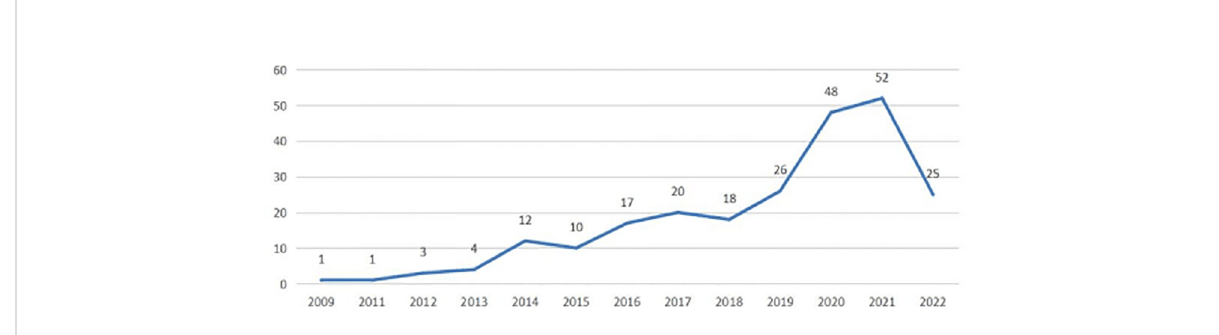
FIGURE 2 Annual statistics of published papers. The abscissa represents time, and the ordinate represents the number of